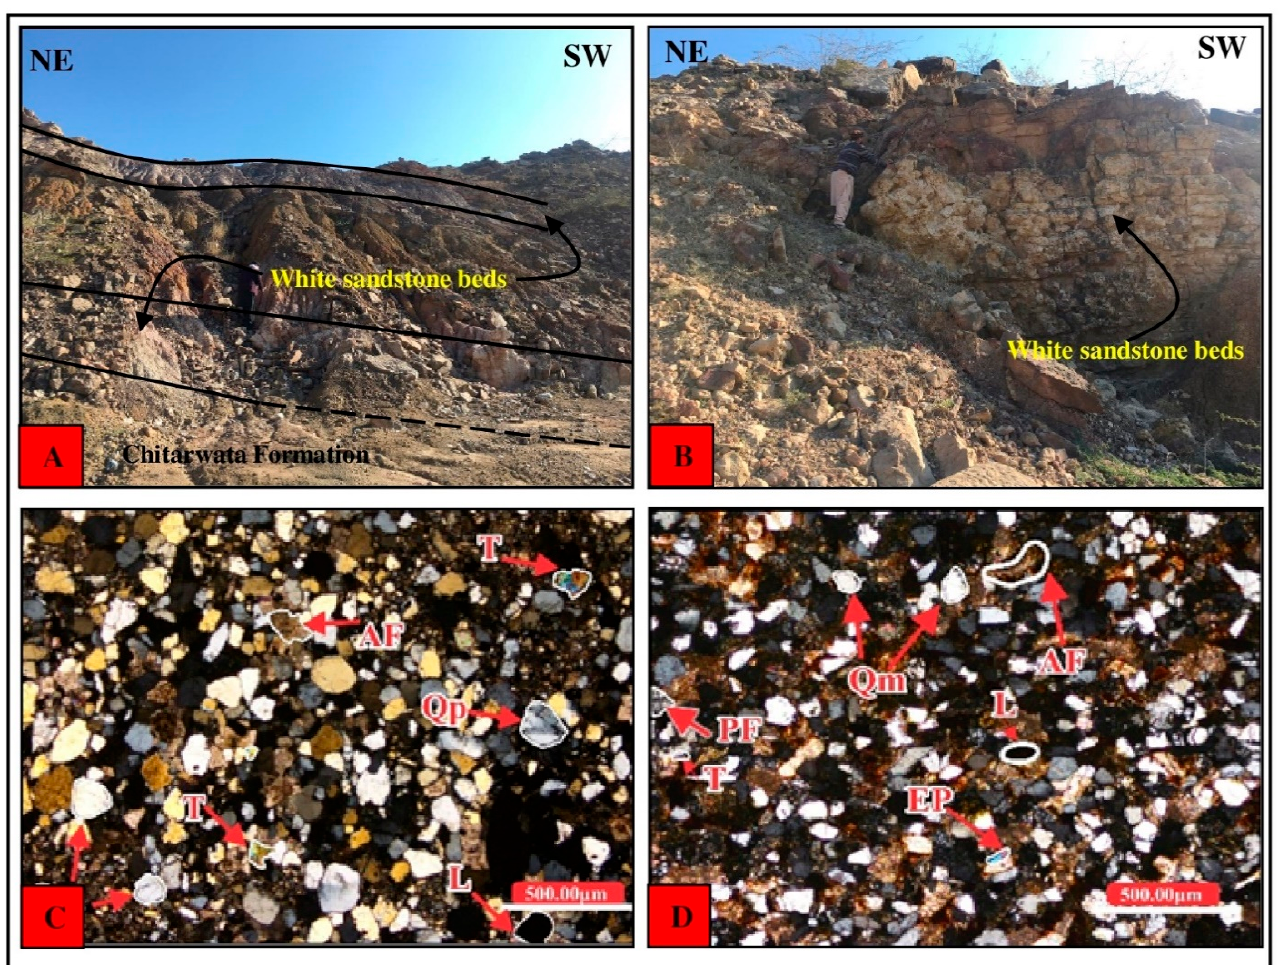
Figure 3. ( A , B ) Field photographs showing sandstone and shales of the Chitarwatta Formation. ( C , D ) Photomicrographs of the sandstone of the Chitarwatta Formation, showing major framework grains and accessory minerals. Where, Qm—monocrystalline quartz, Qp—polycrystalline quartz, AF—alkali feldspar, PF—plagioclase feldspar, L—lithics, Ep—epidote, and T—tourmaline.